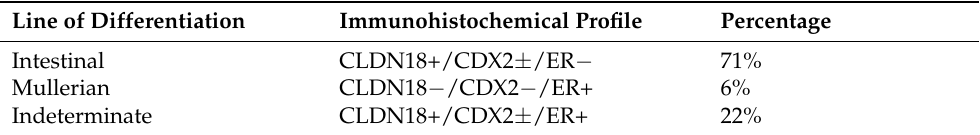
Table 4. Immunohistochemical characteristics of mucinous ovarian neoplasms. Line of Differentiation Immunohistochemical Profile Percentage Intestinal CLDN18+/CDX2 ± /ER − 71% Mullerian CLDN18 − /CDX2 − /ER+ 6% Indeterminate CLDN18+/CDX2 ±